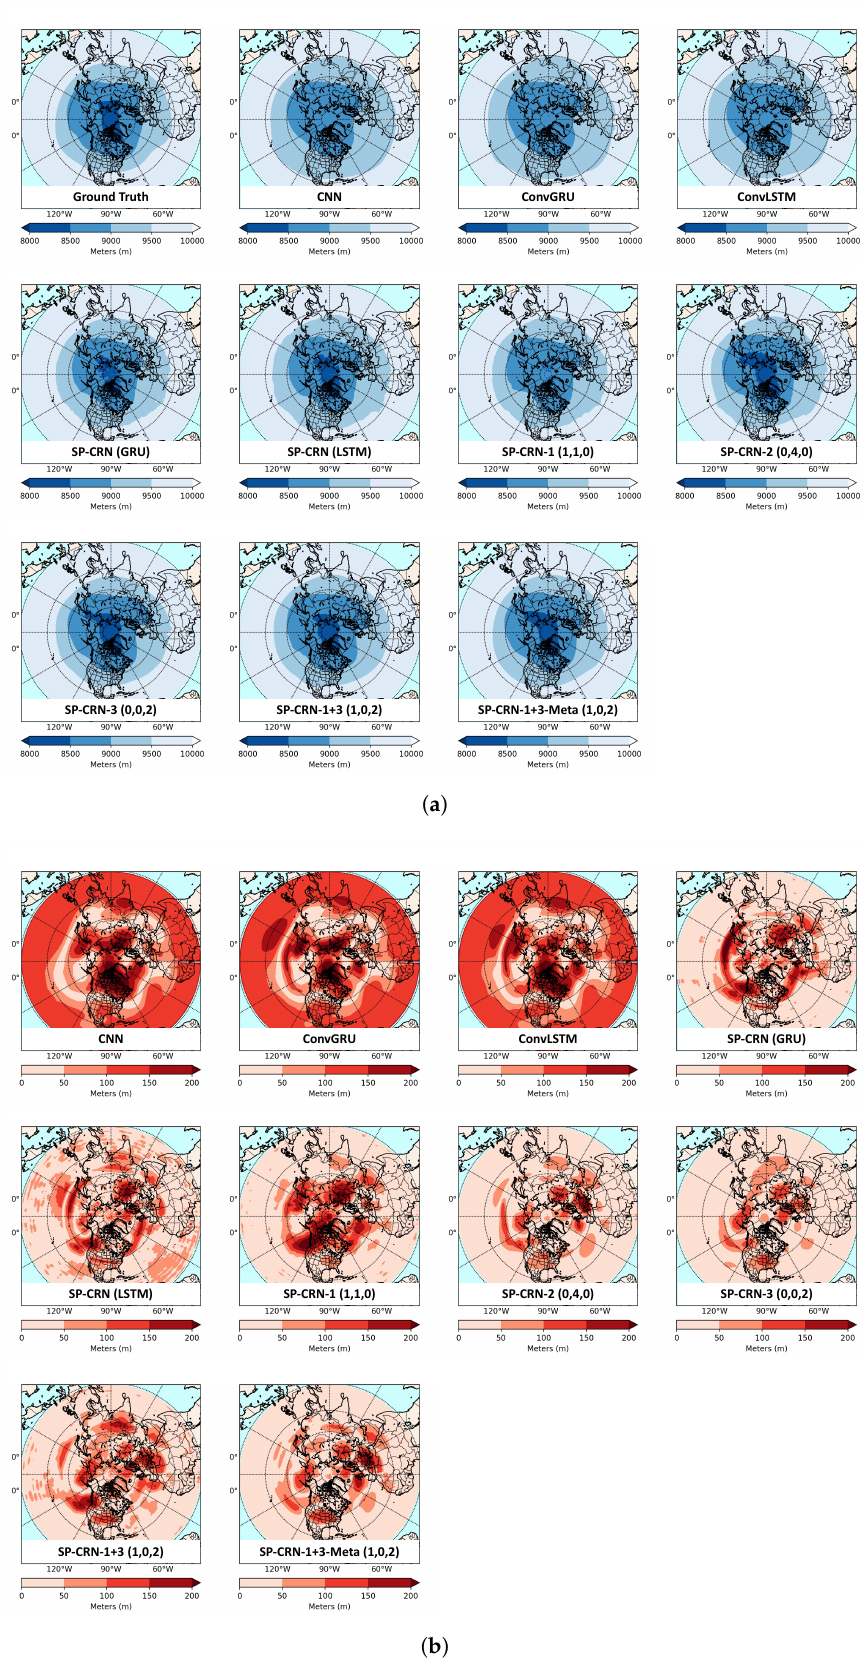
Figure 6. The prediction and error distribution of ZH300 on February 2017 ( a ) Ground truth and prediction results. ( b ) Error distribution (absolute